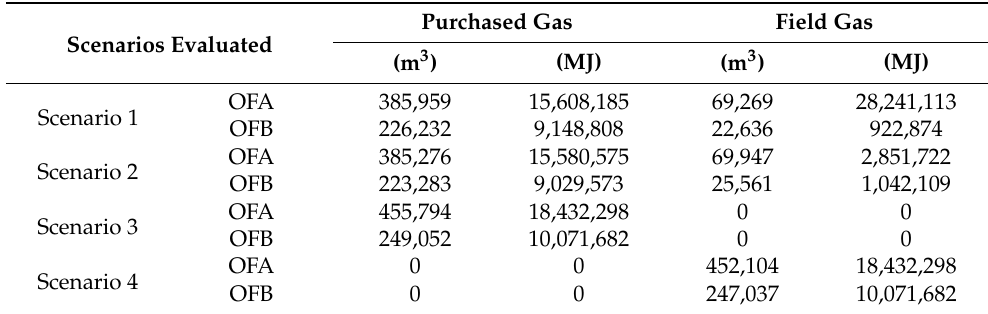
Table 9. Variation in the consumption of non-renewable resources on the carbon footprint in the geothermal energy co-generation